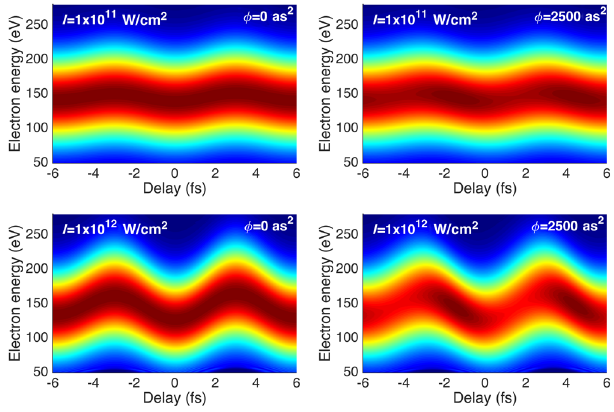
FIG. 11. Statistical noise analysis of an attosecond pulse with similar bandwidth to our experimental data. Top: 1250 as 2 simu- lated; middle: 2500 as 2 simulated; bottom: 5000 as 2